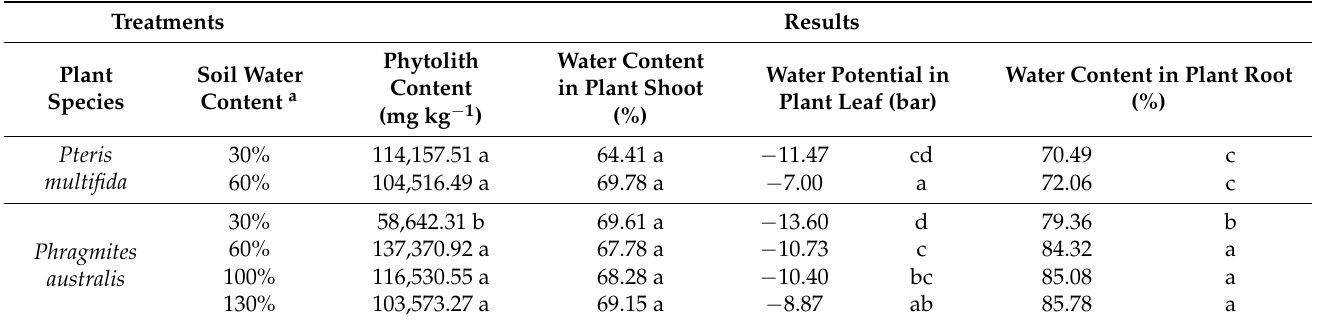
Figure 1. SEM images and EDS spectra of phytoliths from ( a ) P. multifida at 60% water holding capacity soil and ( b ) P. australis at 60% water holding capacity soil. Table 2. Plant water content water potential and phytolith content